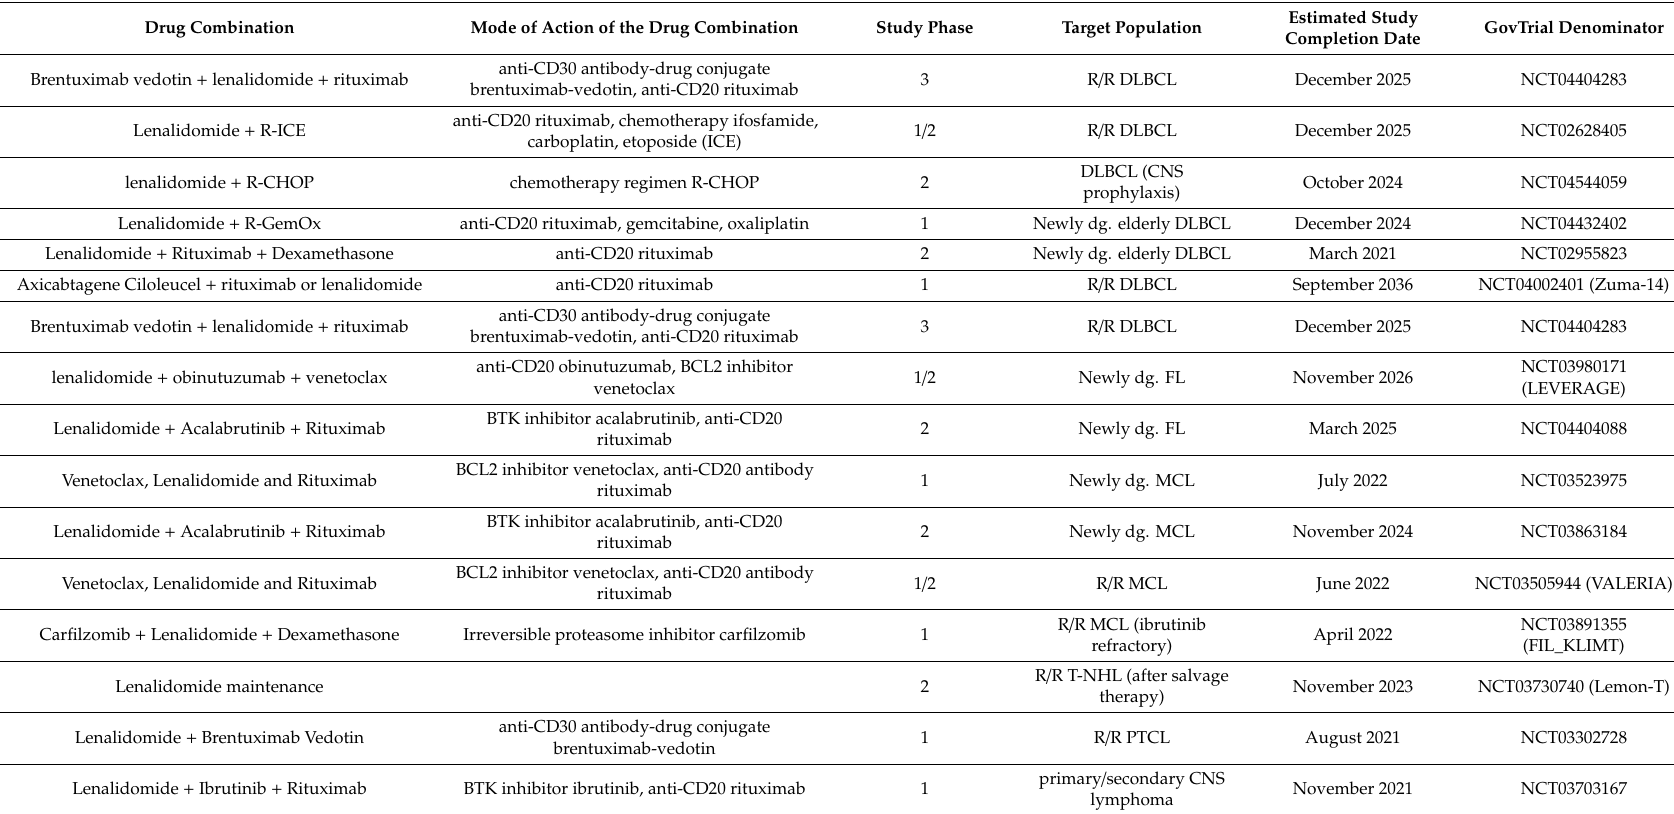
Table 9. Selected clinical studies in NHL that incorporate